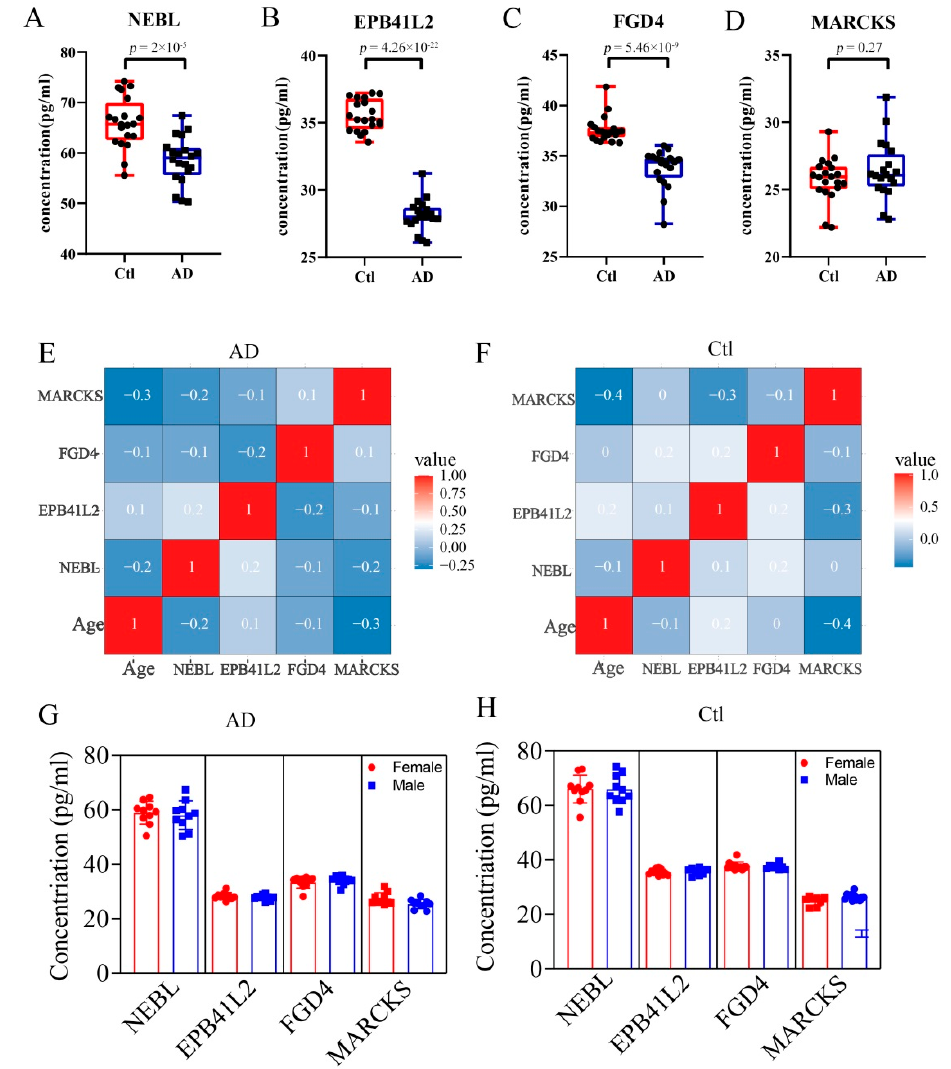
Figure 6. Changes of expression of hub DEPs in the serum. The se-rum concentration of NEBL ( A ), EPB41L2 ( B ), FGD4 ( C ), and MARCKS ( D ) in control and AD groups. ( E , F ) Correlation analysis of age with the four molecules in the AD and control groups, respectively. ( G , H ) The differential expression analyses of these molecules between female or male populations in the AD and control groups, respectively.